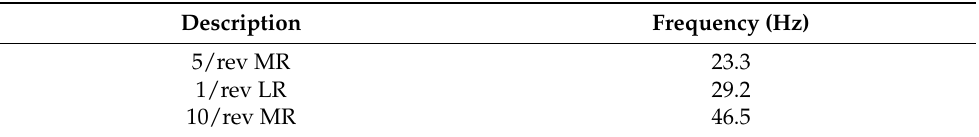
Table 4. Racer H/C dynamic constraints: operating blade passing frequency (BPF) (peak amplitude confidential).